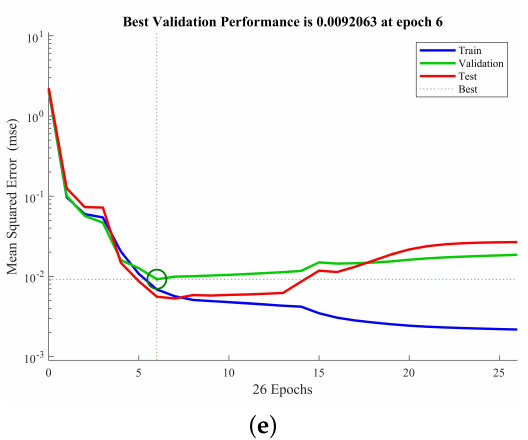
Figure 4. Performance function of the proposed network. ( a ) SPSW; Stiffness, ( b ) SPSW; Strength, ( c ) RCSW; Strength, ( d ) RCSW; Stiffness, ( e ) RCSW; Drift.